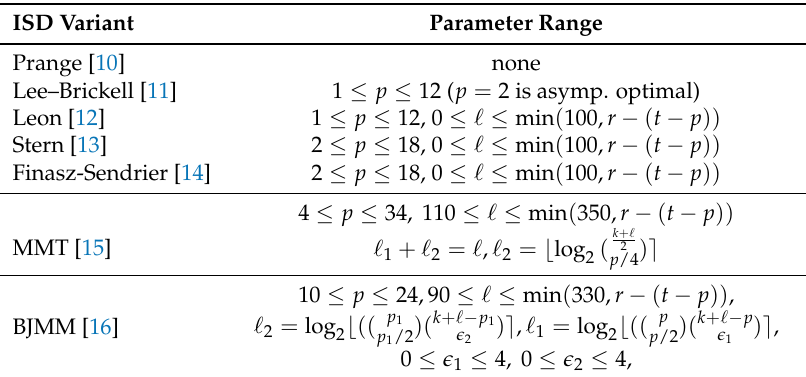
Table 3. Explored parameter range for the different ISD